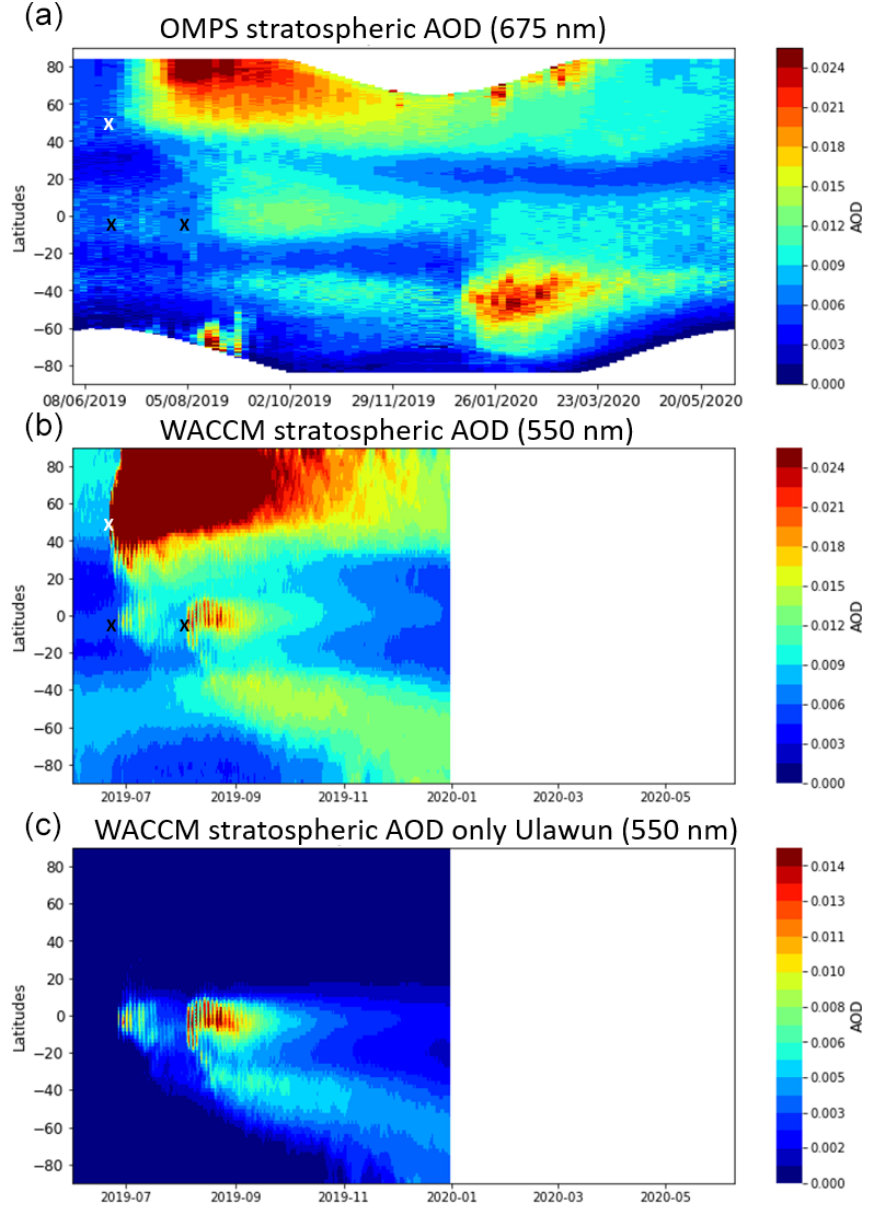
Figure 5. Latitude/time global distribution of the longitude-averaged sAOD. (a) For OMPS observations and (b) the integrated stratospheric column for the WACCM simulation for both eruptions and (c) for the Ulawun-only WACCM simulations. Crosses symbolize the position and timing of the eruptions, white for Raikoke and black for Ulawun. The WACCM sAOD is shown here for sulfate only, i.e., with no condensation of water, to eliminate the signature of PSCs in the winter hemisphere, which would likely mask the signature of the plume closer to the